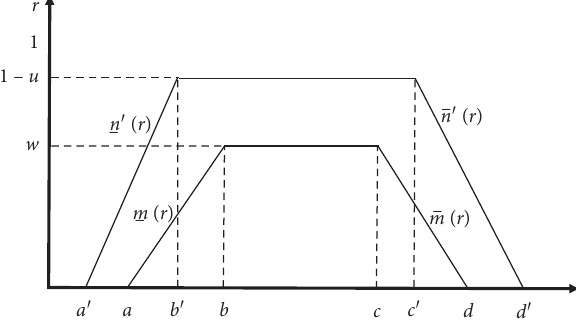
Figure 5: m ( r ) , m ( r ) , n ′ ( r ) , and n ′ ( r ) of a TraIFN 􏽥 A